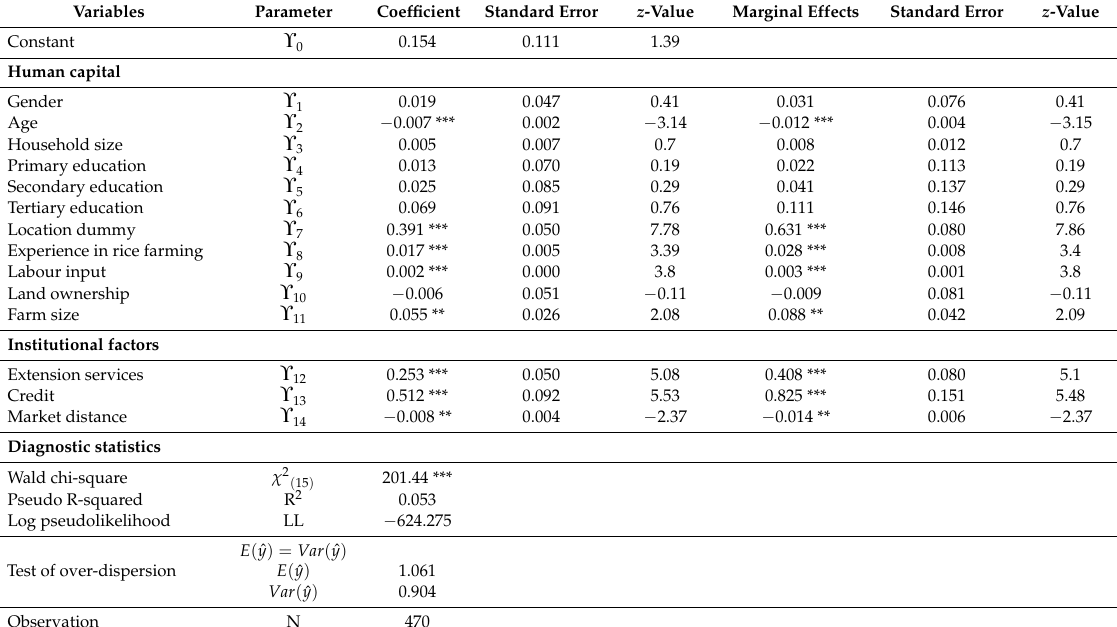
Table 3. Determinants of the number of innovations adopted by rice